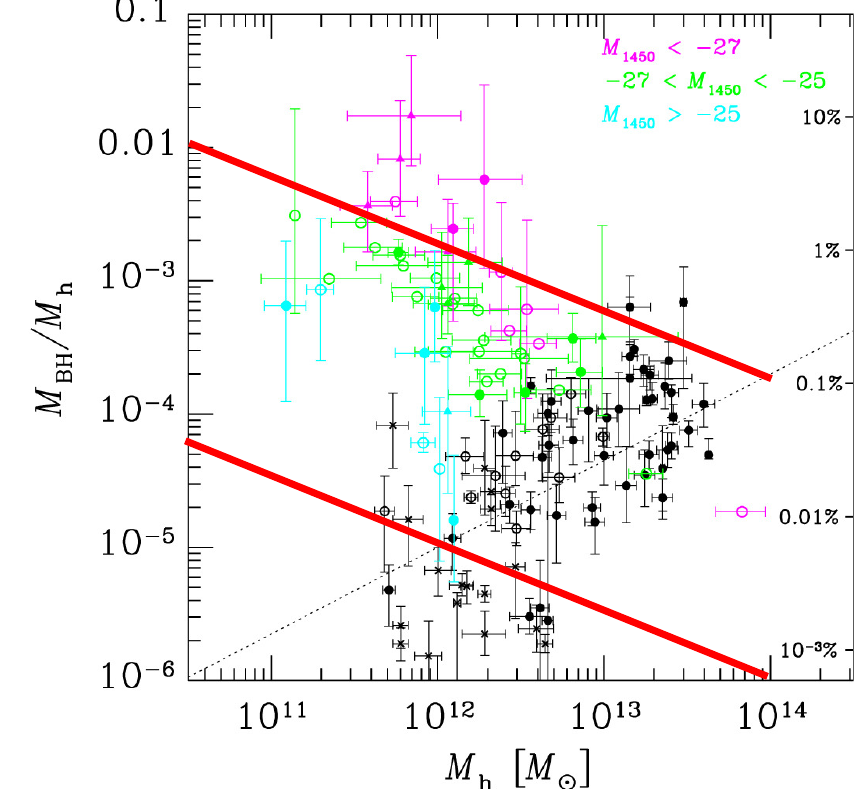
Figure 3. The mass ratio of SMBH and DH M BH / M DH as a function of M DH : observational data and our estimates. M h in the figure is the same as our M DH . On top of the observational figure from [34] Figure 3b, our estimates Equation (39) (lower red line) and Equation (42) (upper red line) are plotted. z ≈ 6 − 7 objects are colored depending on M 1450 (rest frame 1450 ◦ A absolute magnitude: magenta, brighter than −27; green, −27 to −25; cyan, fainter than −25). Black symbols are data of local galaxies quoted from [35] in [34]: ellipticals • , classical bulges ◦ , and pseudo bulges × . A detailed explanation is in